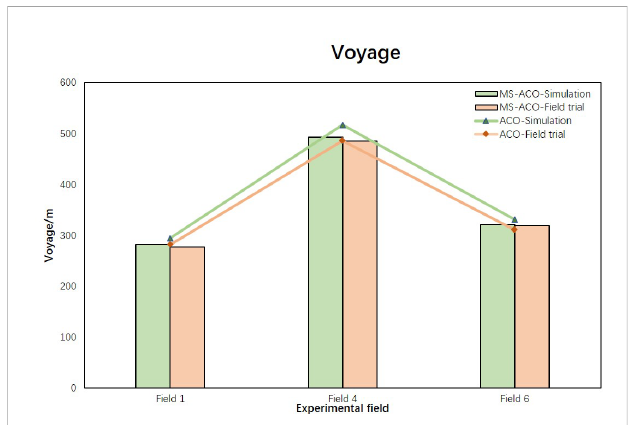
FIGURE 9 Comparison of path results between simulation experiment and fi eld experiment.